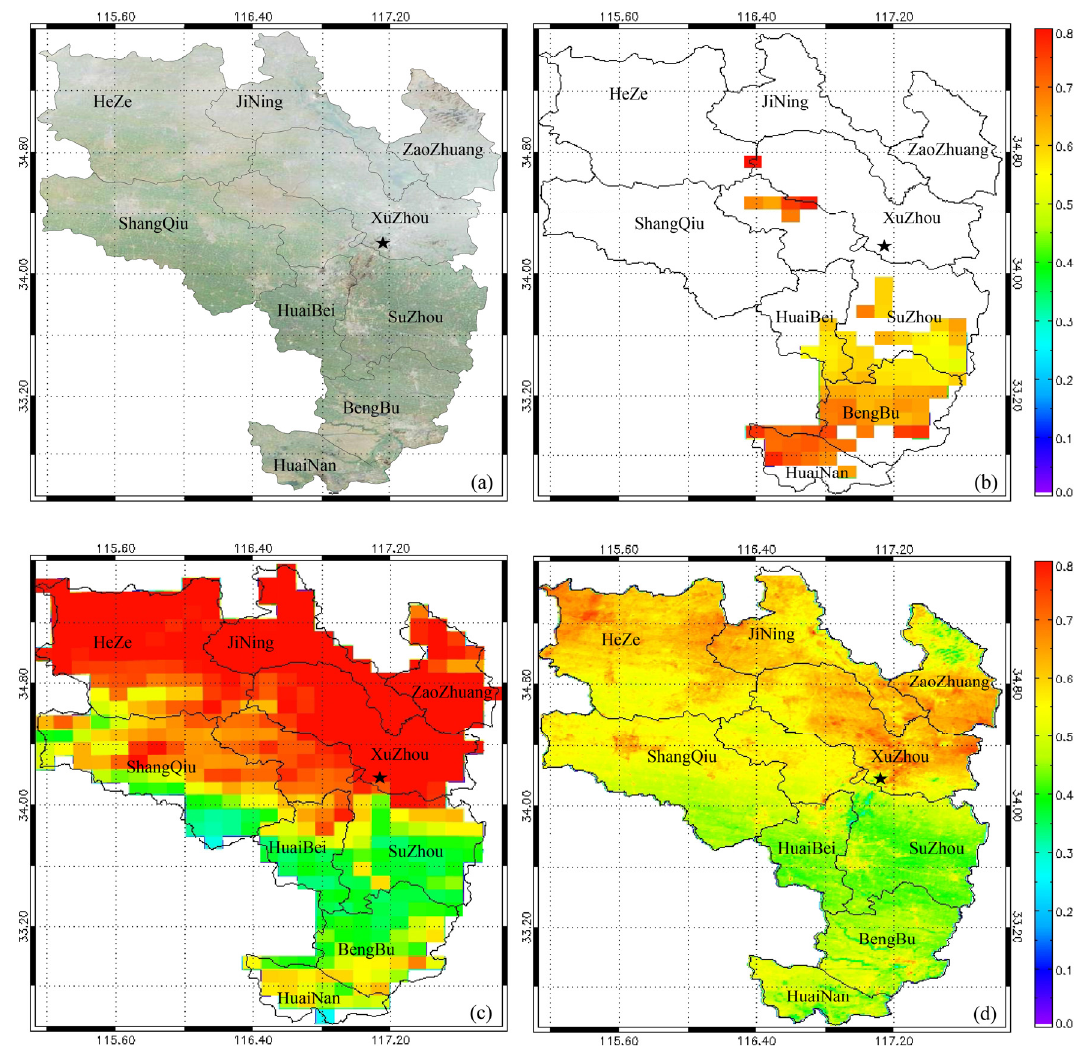
Figure 5. Contrast of satellite-derived AOD results in the study region on 11 January 2015. ( a ) True color (RGB:143); ( b ) Terra DT AOD at 10 km; ( c ) Terra DB AOD at 10 km; ( d ) Terra SARA AOD at 500 m.